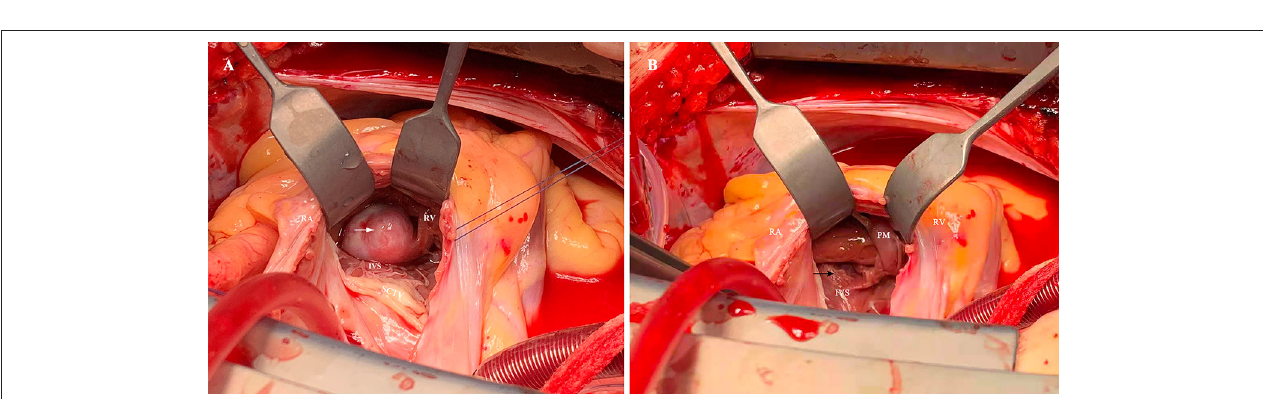
FIGURE 2 | (A,B) Magnetic resonance imaging demonstrated that a well-circumscribed homogenous nodule, measuring 16 × 13mm, with medium signal intensity on T1-weighted images and medium signal intensity on T2- weighted images in the right ventricle, located adjacent to the IVS, was revealed uniform moderate enhancement for the first perfusion scan and uniform significantly delayed enhancement subsequently. RV, right ventricle; IVS, interventricular septum; LV, left ventricle.